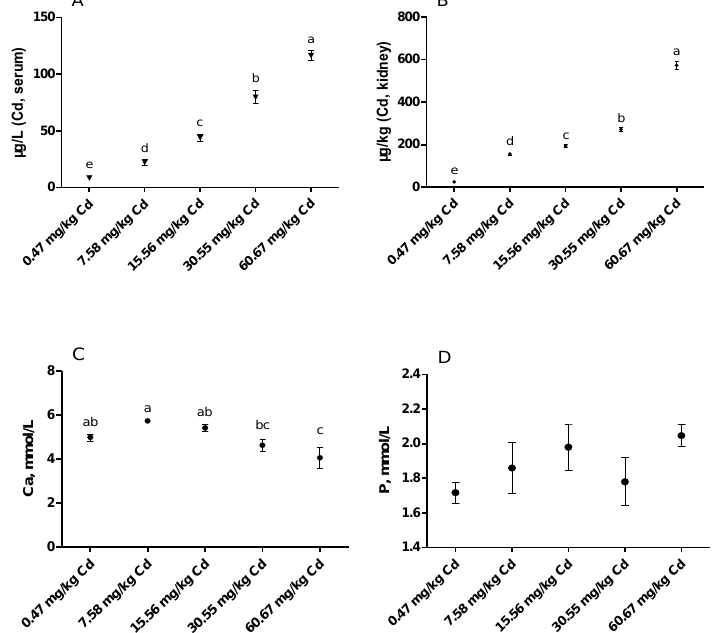
Figure 1. Effects of Cd on Cd, Ca and P levels in the serum and kidney of laying hens. ( A ) serum Cd level; ( B ) Cd level in the kidney; ( C ) serum Ca level; ( D ) serum P level. Values are presented as the mean ± SE ( n = 8). a–e Means with different superscript letters are significantly different ( p < 0.05).